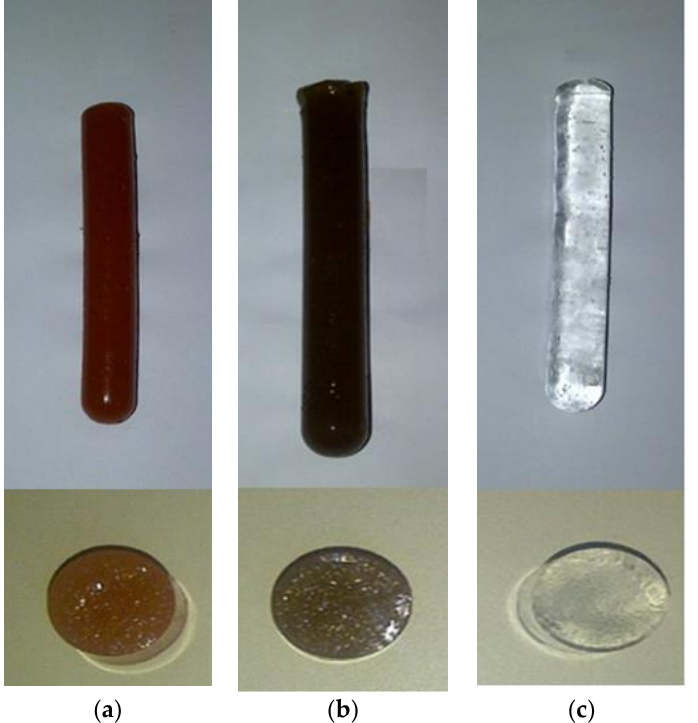
Figure 9. Images of synthesized hydrogels: ( a ) PAAm/RM hybrid HG; ( b ) PAAm/FeSiMn hybrid HG; ( c ) PAAm conventional HG.